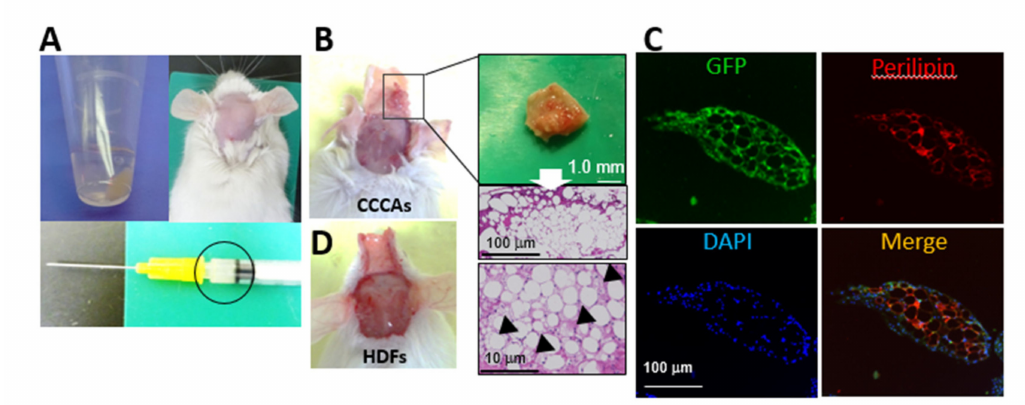
Figure 6. CCCAs reside in granulation tissue after subcutaneous implantation in mice. NOG/SCID mice were implanted with GFP-labeled CCCAs or GFP-labeled HDFs ( A , upper left and lower panels) in the supraperiosteal plane of the skull ( A , upper right) ( n = 4 mice per group). Four weeks later granulation tissue containing fat was observed at the site implanted with GFP-labeled CCCAs ( B ). Tissue sections were subjected to HE and immunohistochemical staining using anti-perilipin antibody, and cell nuclei were also stained with DAPI. The arrowheds indicates adipocyte with multi-locular lipid droplets ( C ). No granulation tissue was found in mice implanted with GFP-labeled HDFs ( D